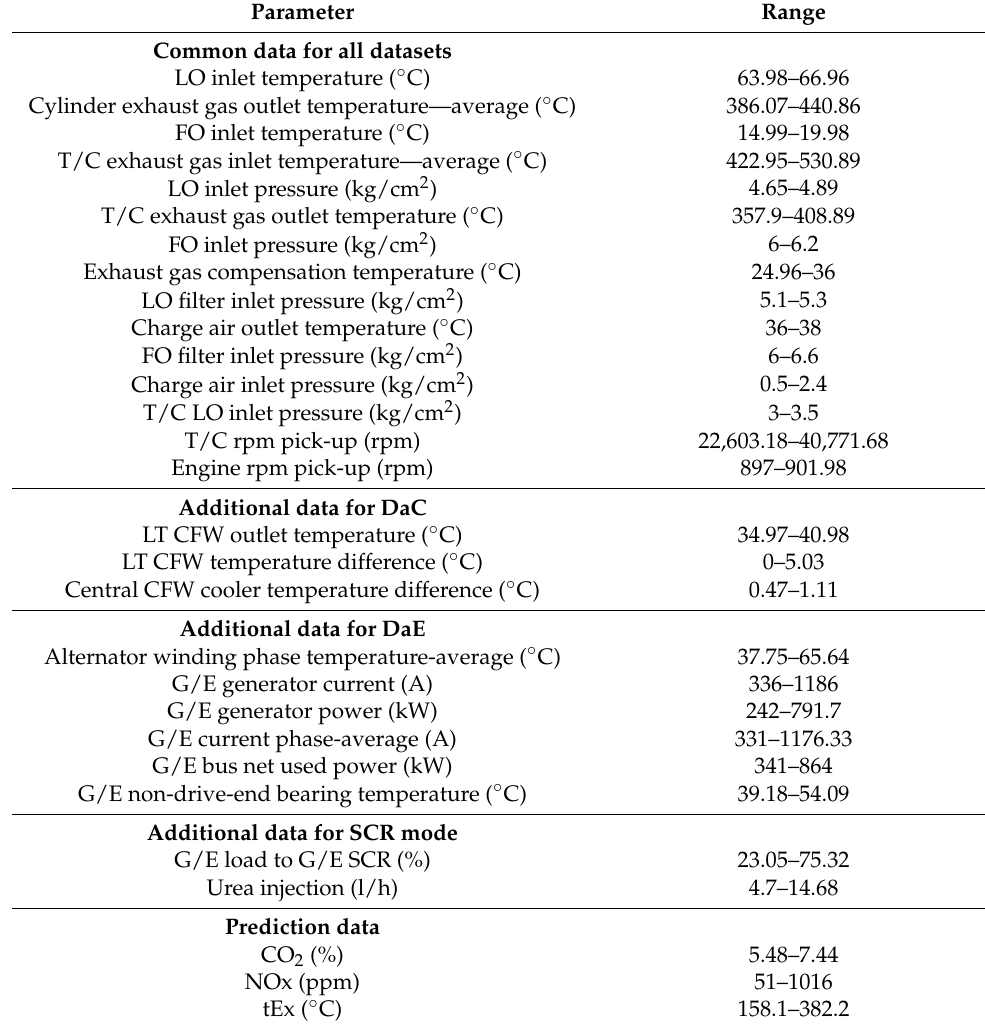
Table 6. Parameters and their ranges for the emission prediction model. Parameter